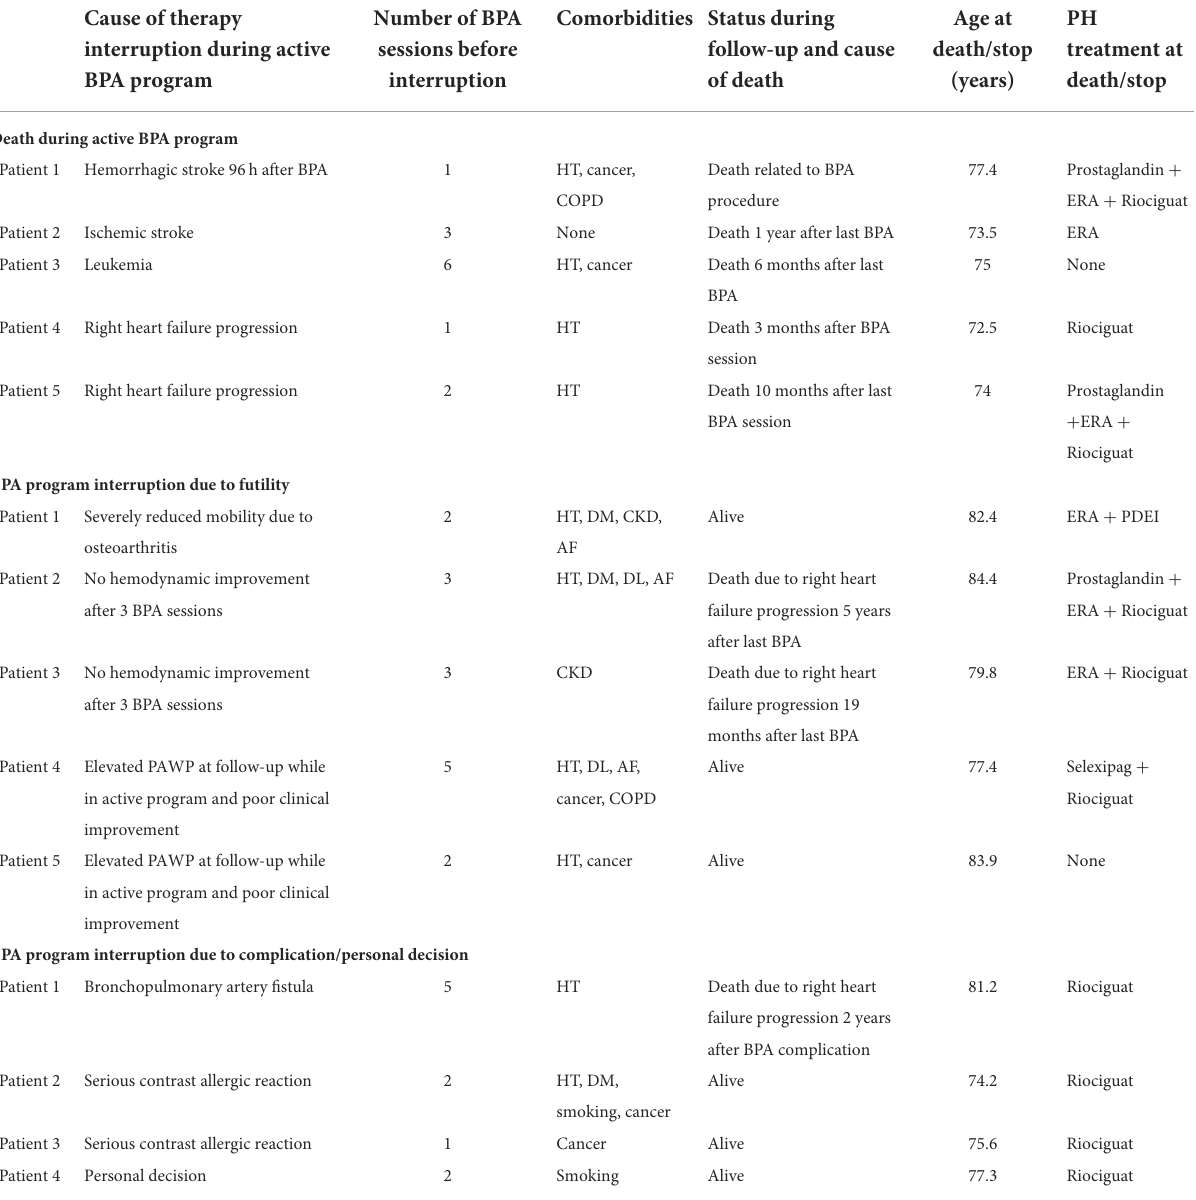
TABLE 3 Causes of death, interruption, and futility considerations in the group with BPA therapy interruption. Cause of